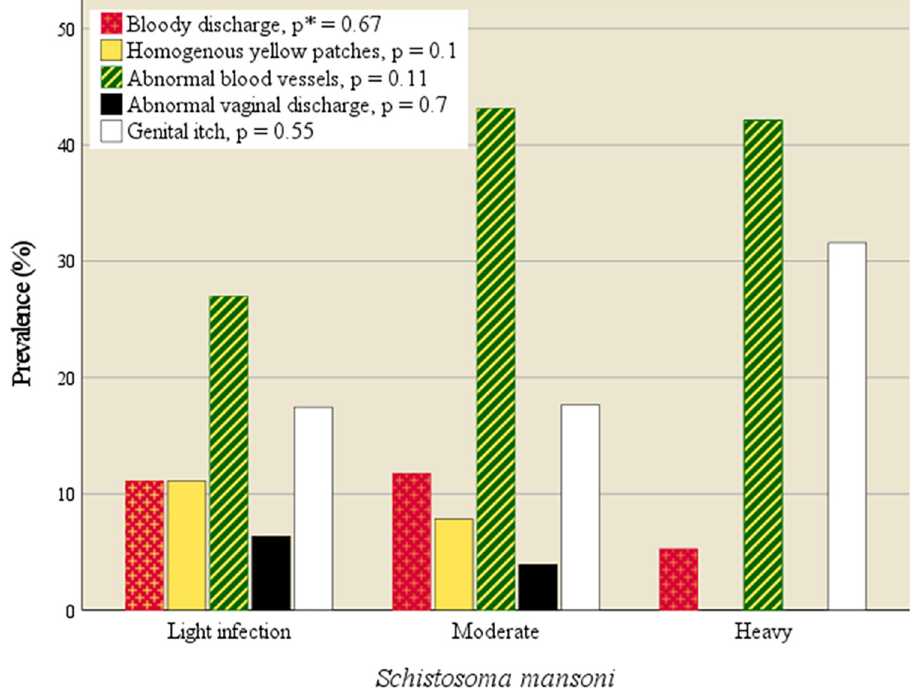
Fig 3. Genital symptoms and findings by S . mansoni intensity. No significant association between symptoms and intensity of S . mansoni . � Likelihood ratio p-value.